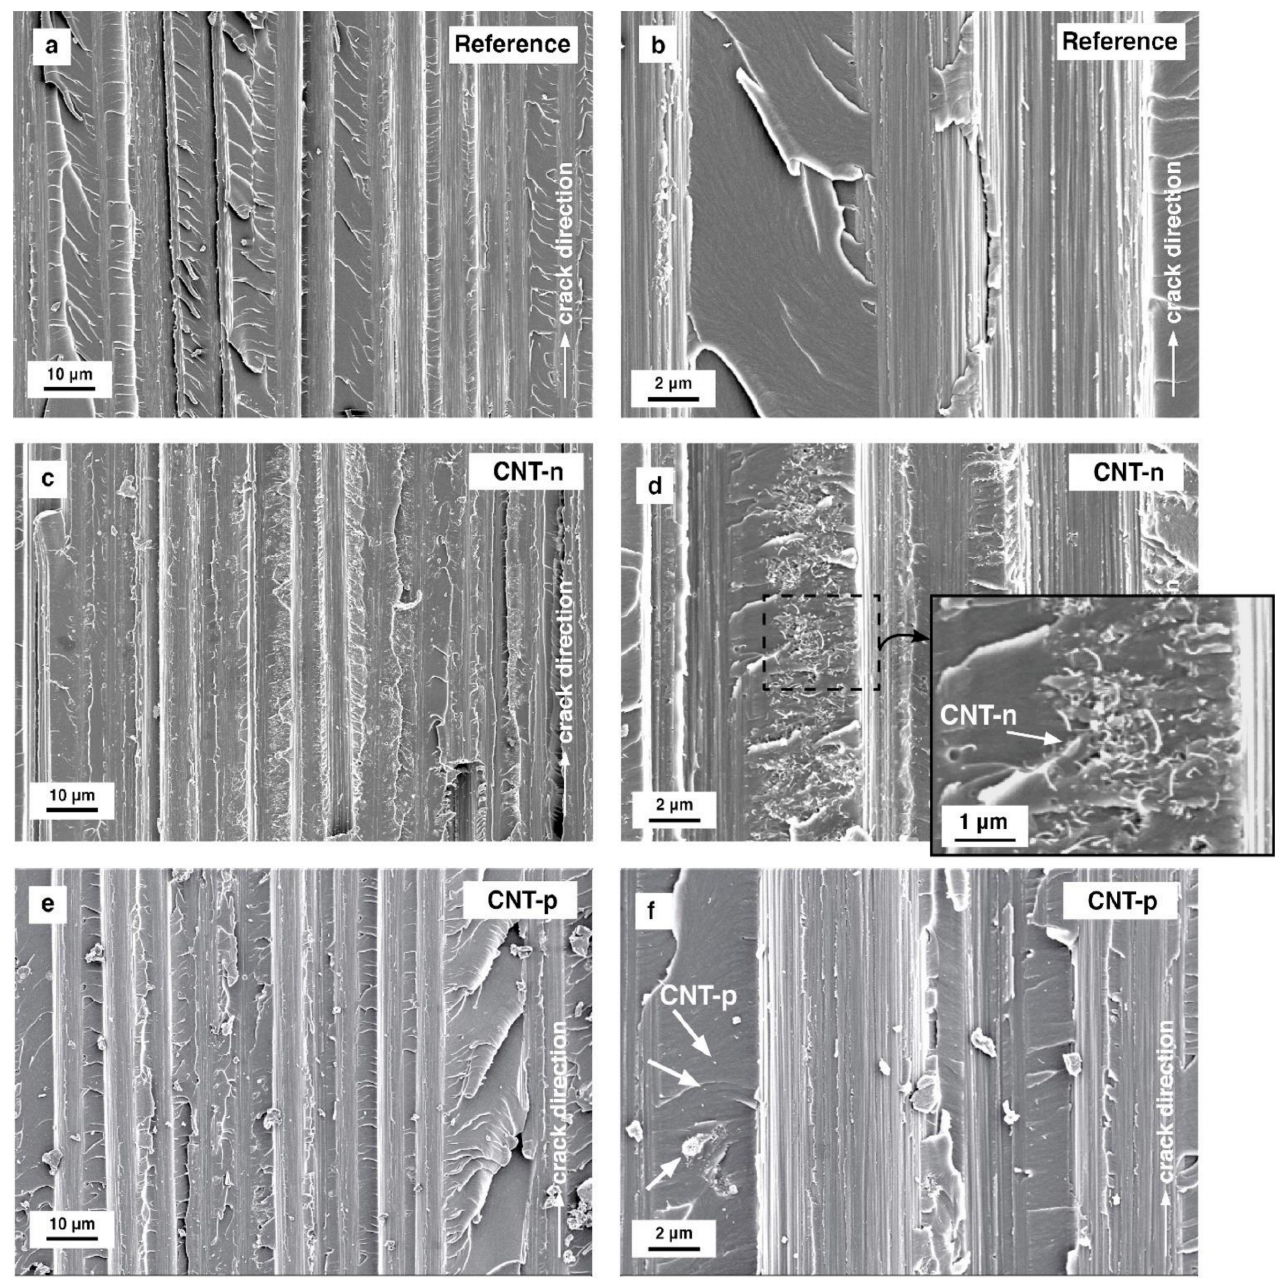
Figure 10. Scanning electron micrographs of fracture surfaces from ( a ) and ( b ) neat, ( c ) and ( d ) 0.5 wt.% CNT-n modified, and ( e ) and ( f ) 0.5 wt.% CNT-p modified epoxy–carbon fiber UD prepreg laminates tested under mode I loading. White arrows indicate the crack propagation